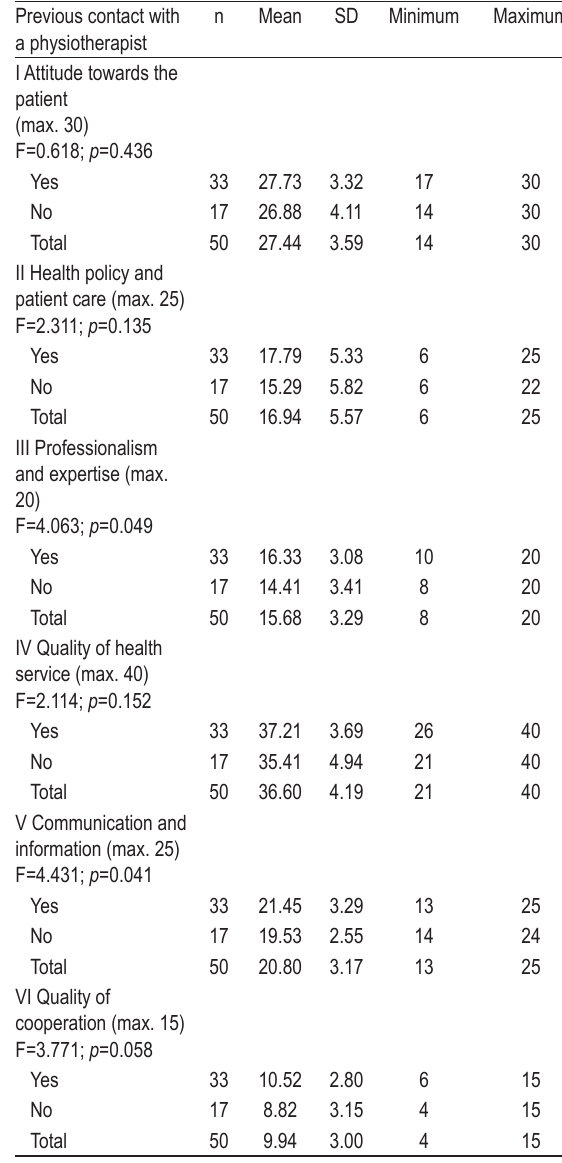
TABLE 10. Impact of previous contact with a physiotherapist on the field of research